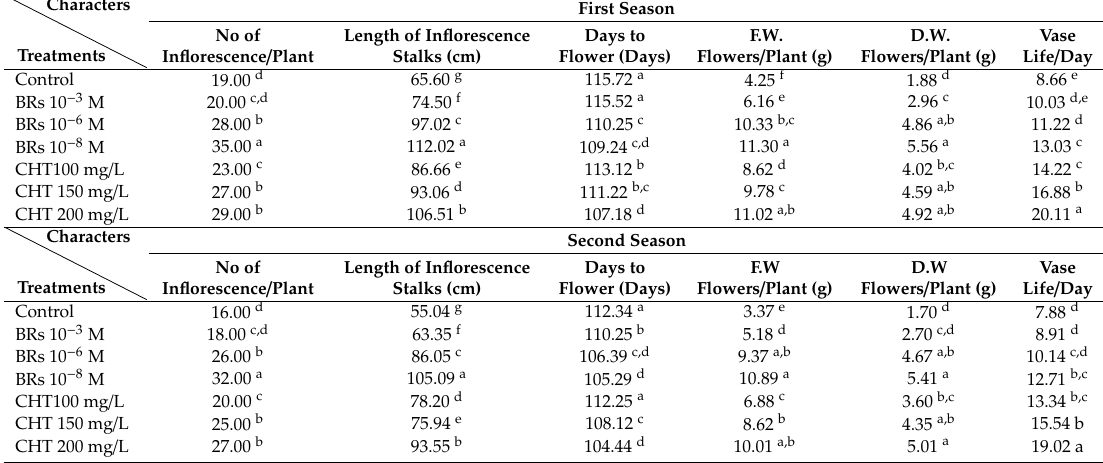
Table 4. E ff ect of di ff erent concentrations of brassinosteroids and chitosan on flowering characteristics of Solidago canadensis cv. Tara plant during 2018 and